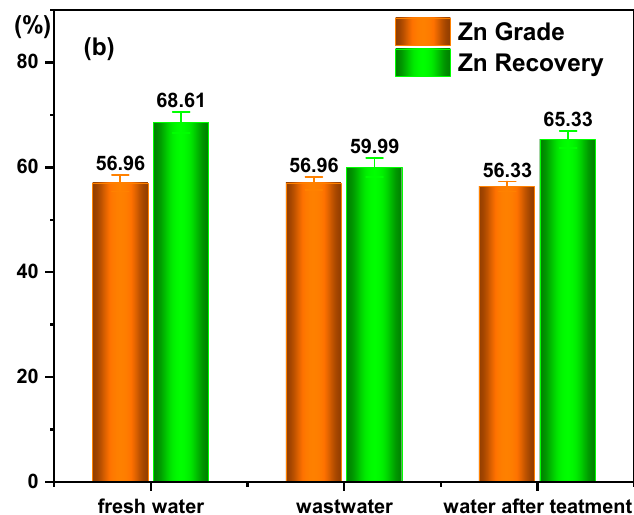
Figure 10. The grade and recovery of Pb ( a ) and Zn ( b ) sulfide flotation concentrates using different types of water.